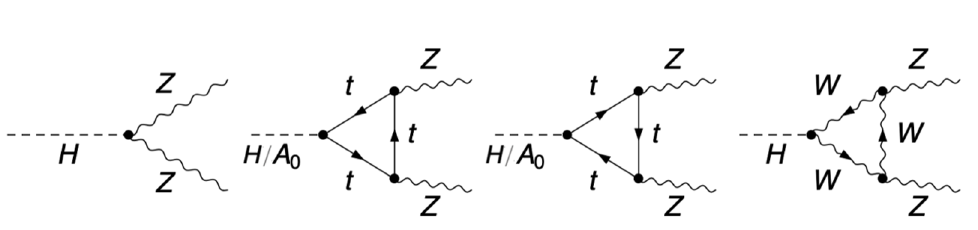
Figure 7 . Feynman diagrams for the coupling of CP-even ( H ) and CP-odd ( A 0 ) Higgs fields to two Z bosons, at tree and one-loop